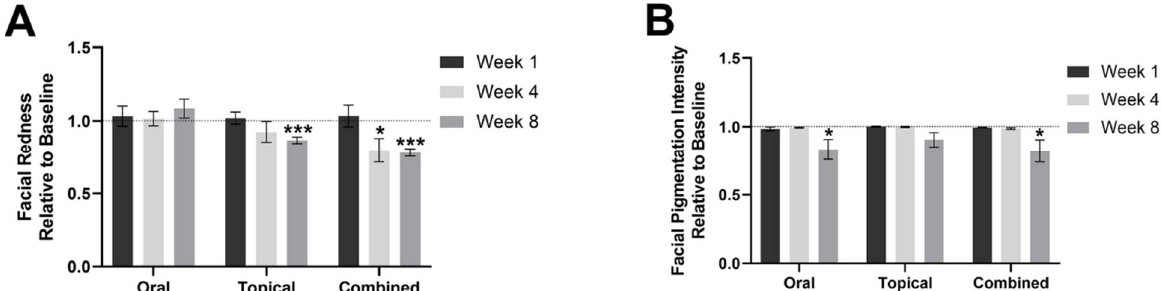
Figure 1. Mean facial redness and pigmentation in the oral, combined and topical groups at 1 week, 4 weeks, and 8 weeks, relative to the baseline. ( A ) Mean facial redness in the oral, combined and topical groups at 1 week, 4 weeks, and 8 weeks, relative to the baseline. ( B ) Mean facial pigmentation in oral, combined, and topical at 1 week, 4 weeks, and 8 weeks, relative to the baseline. * p < 0.05; and *** p < 0.001.